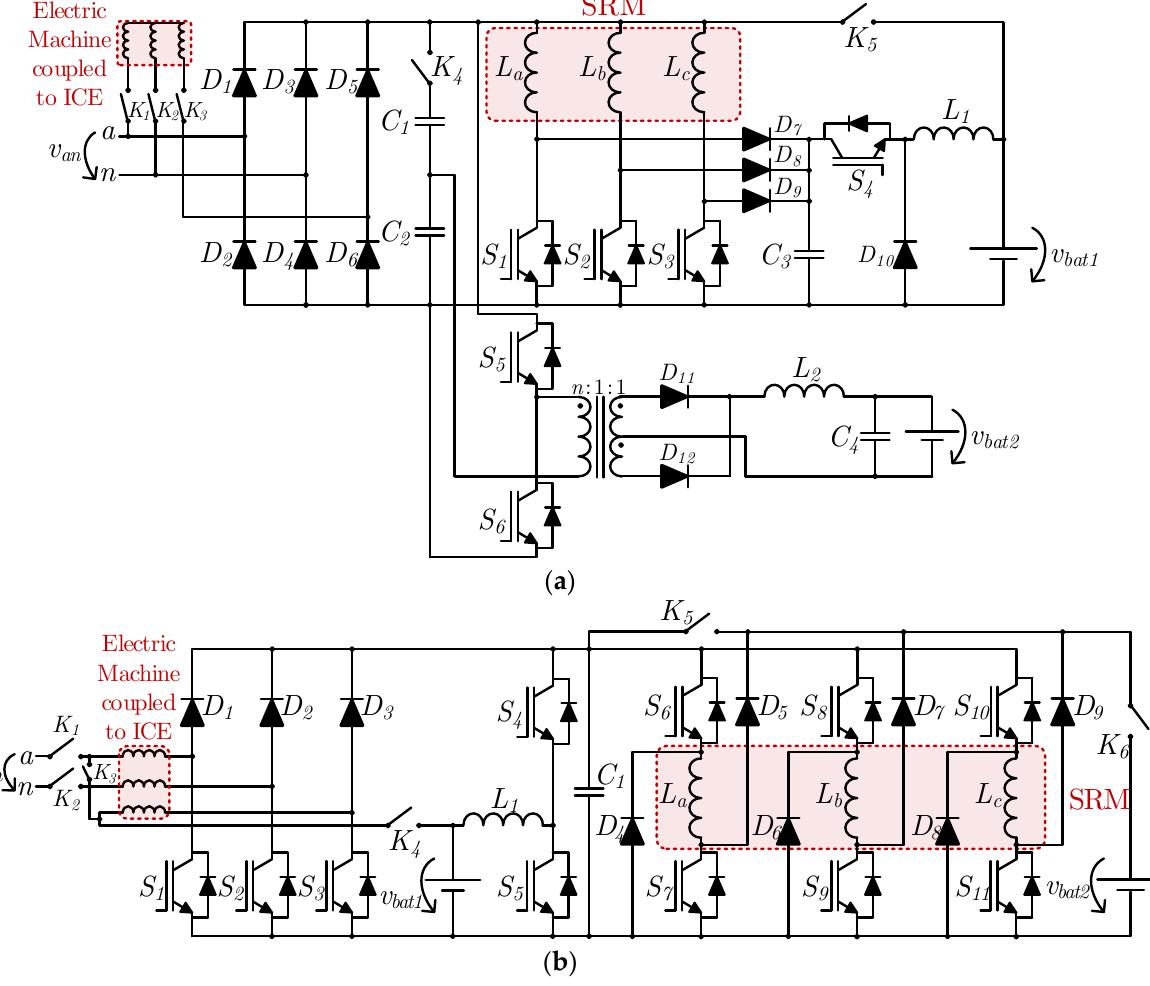
Figure 11. IBCs for plug-in hybrid vehicles based on SRMs proposed by H. Cheng et al. in 2020: ( a ) [25]; ( b ) [26].